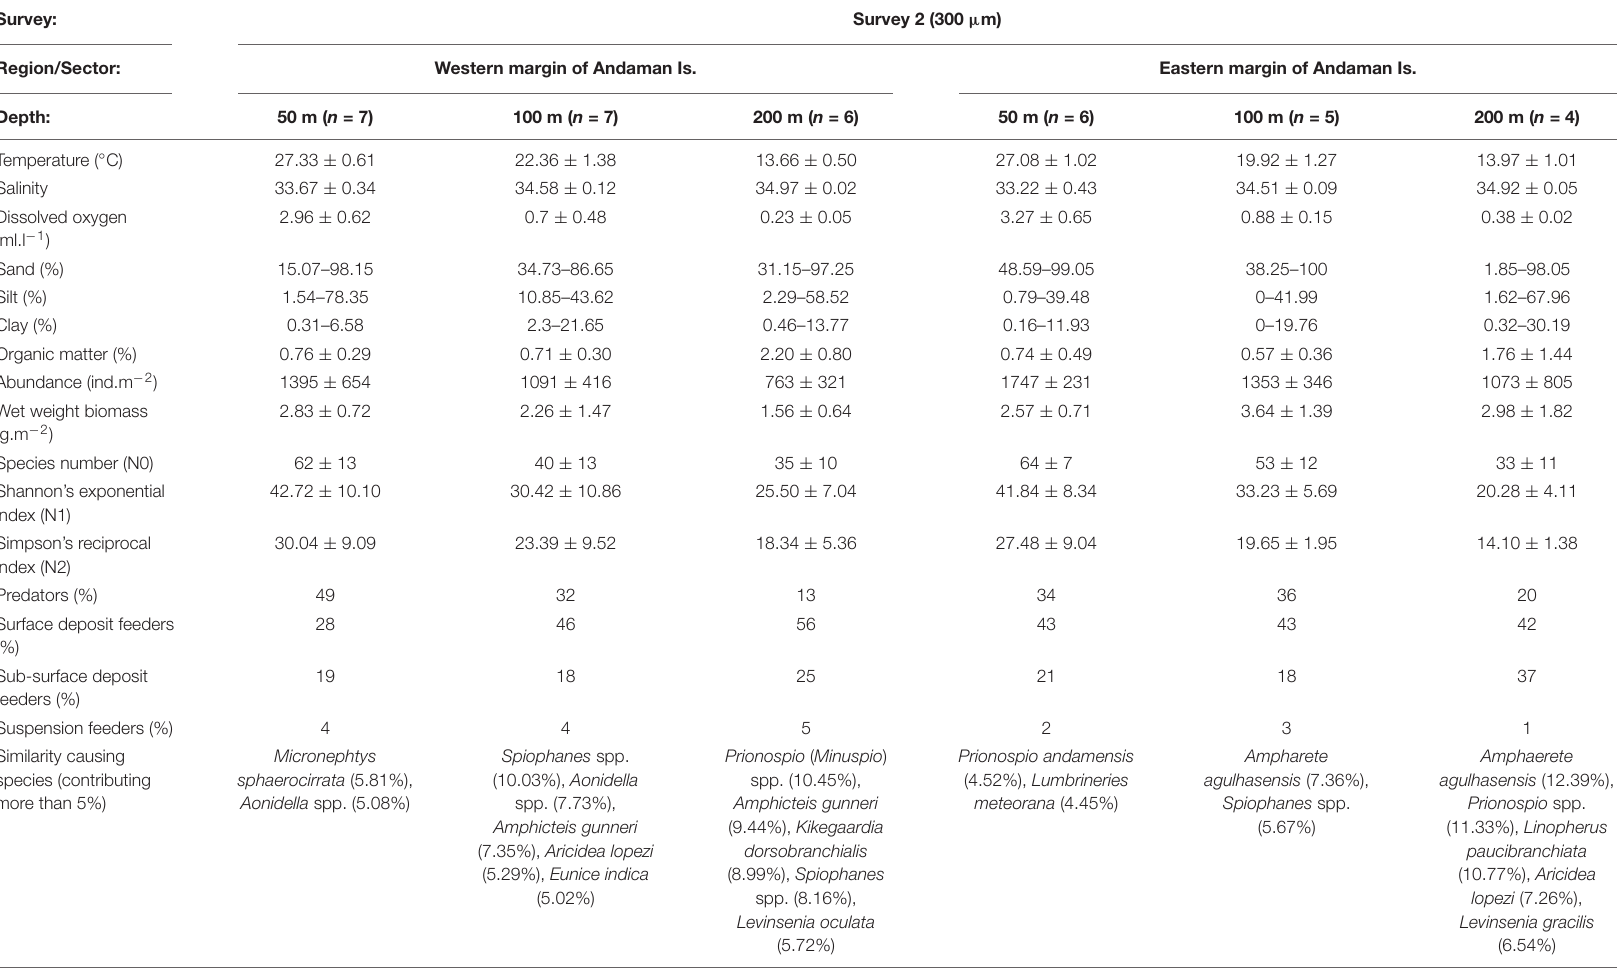
TABLE 4C | Biological characteristics of the polychaete species assemblages along western (WAI) and eastern (EAI) margins of the Andaman Islands in Survey 2 (300 µ m) with prevailing environmental conditions [mean ± SD, n = No. of samples]. Survey: Survey 2 (300 µ m) Western margin of Andaman Is. Eastern margin of Andaman